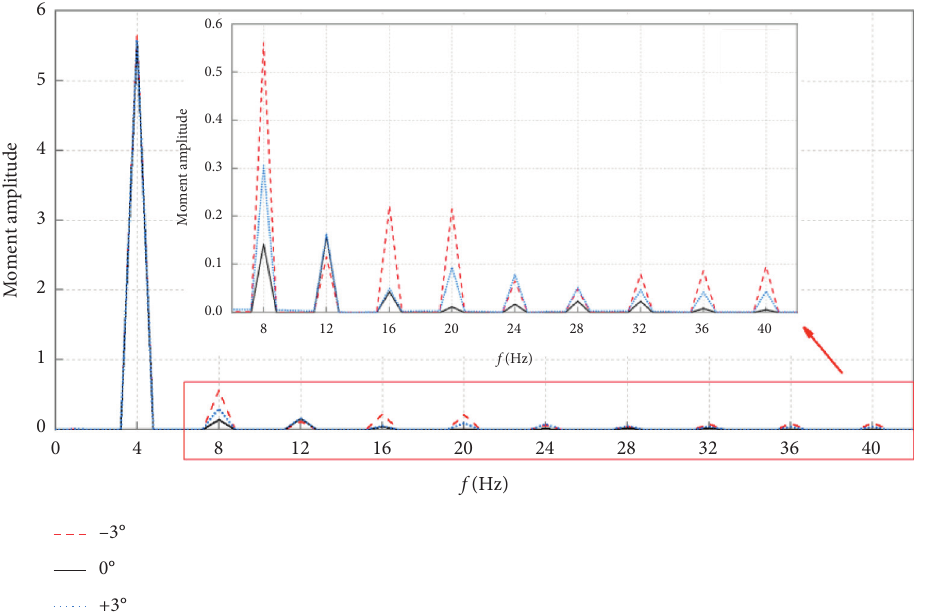
Figure 20: Aerodynamic moment spectrum under single frequency pitching motion of large